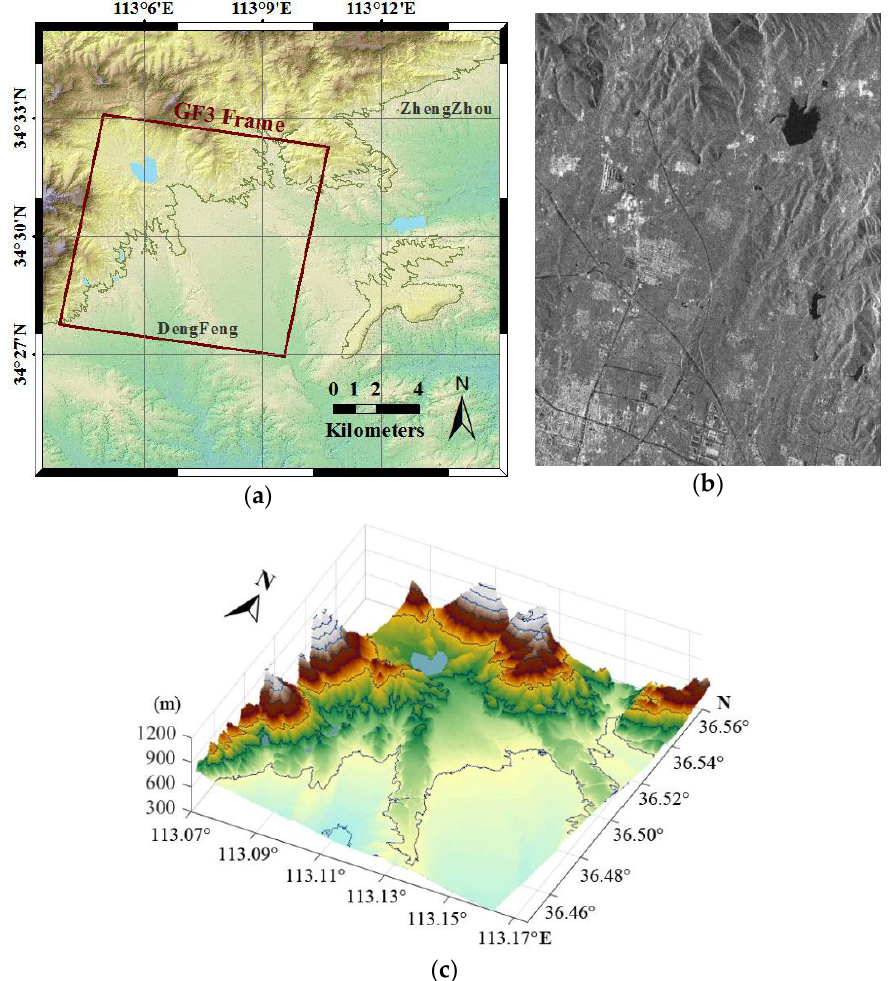
Figure 1. Geographical coverage (Dengfeng area, China) of experimental dataset of the Gaofen-3 (GF3) satellite ( a ), single look complex intensity image from the GF-3 satellite in the Dengfeng area ( b ), and the corresponding distribution of elevation acquired by the Shuttle Radar Topography Mission ( c ). Table 3. Gaofen-3 satellite data of experimental area (Dengfeng area, China).